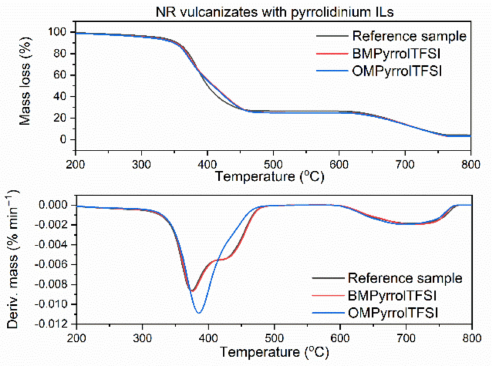
Figure 6. Thermogravimetric (TG) and derivative thermogravimetric (DTG) curves of the NR vulcanizates containing pyrrolidinium ILs with TFSI anion.